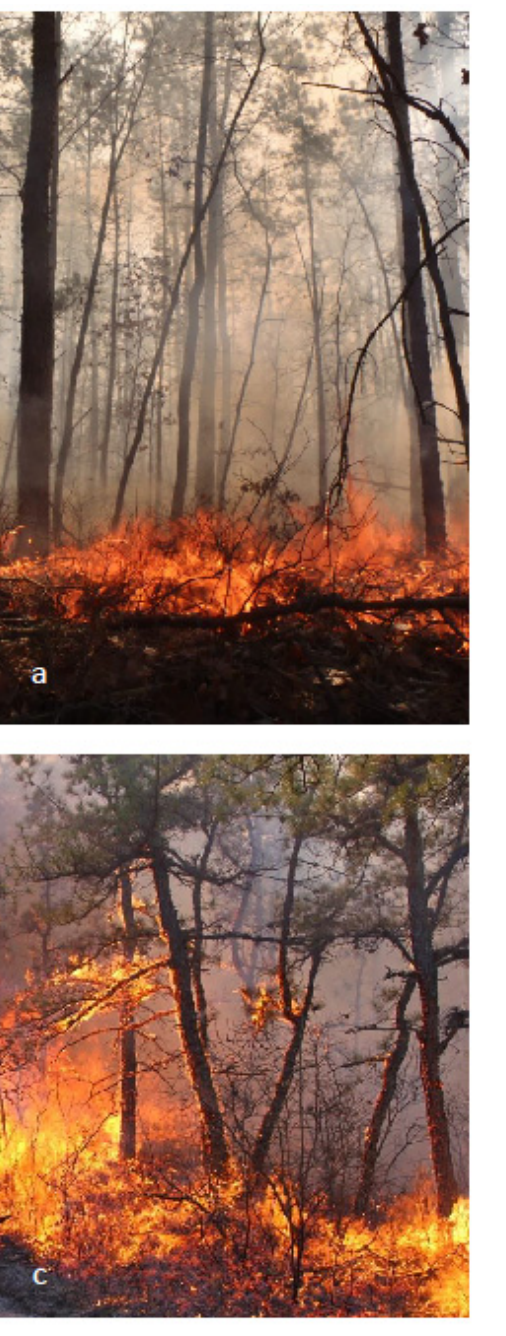
Figure 1. Examples of fire behavior during the eight prescribed fires conducted in the New Jersey Pinelands National Reserve. ( a ) low-intensity backing fire in a pine–oak stand at the Silas Little Experimental Forest in 2012; ( b ) low-intensity backing fire in a pitch pine–scrub oak stand near the Cedar Bridge fire tower in 2013; note the eddy flux tower in the background; ( c ) high-intensity head fire initiating crown torching in a pitch pine–scrub oak stand near Warren Grove in 2014, and ( d ) one of the flux towers following a high-intensity head fire near Warren Grove in 2014.